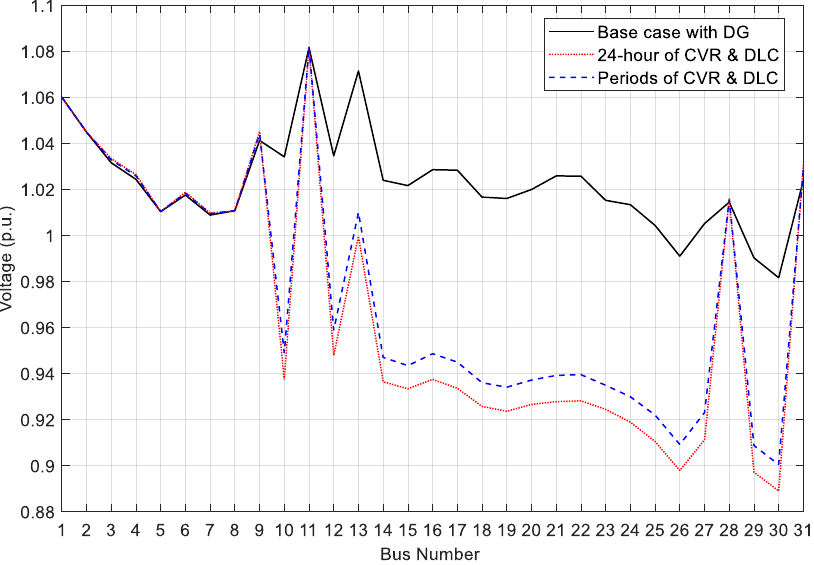
Figure 18. Case VIII: Voltage profile with/without CVR and DLC in the presence of DG.